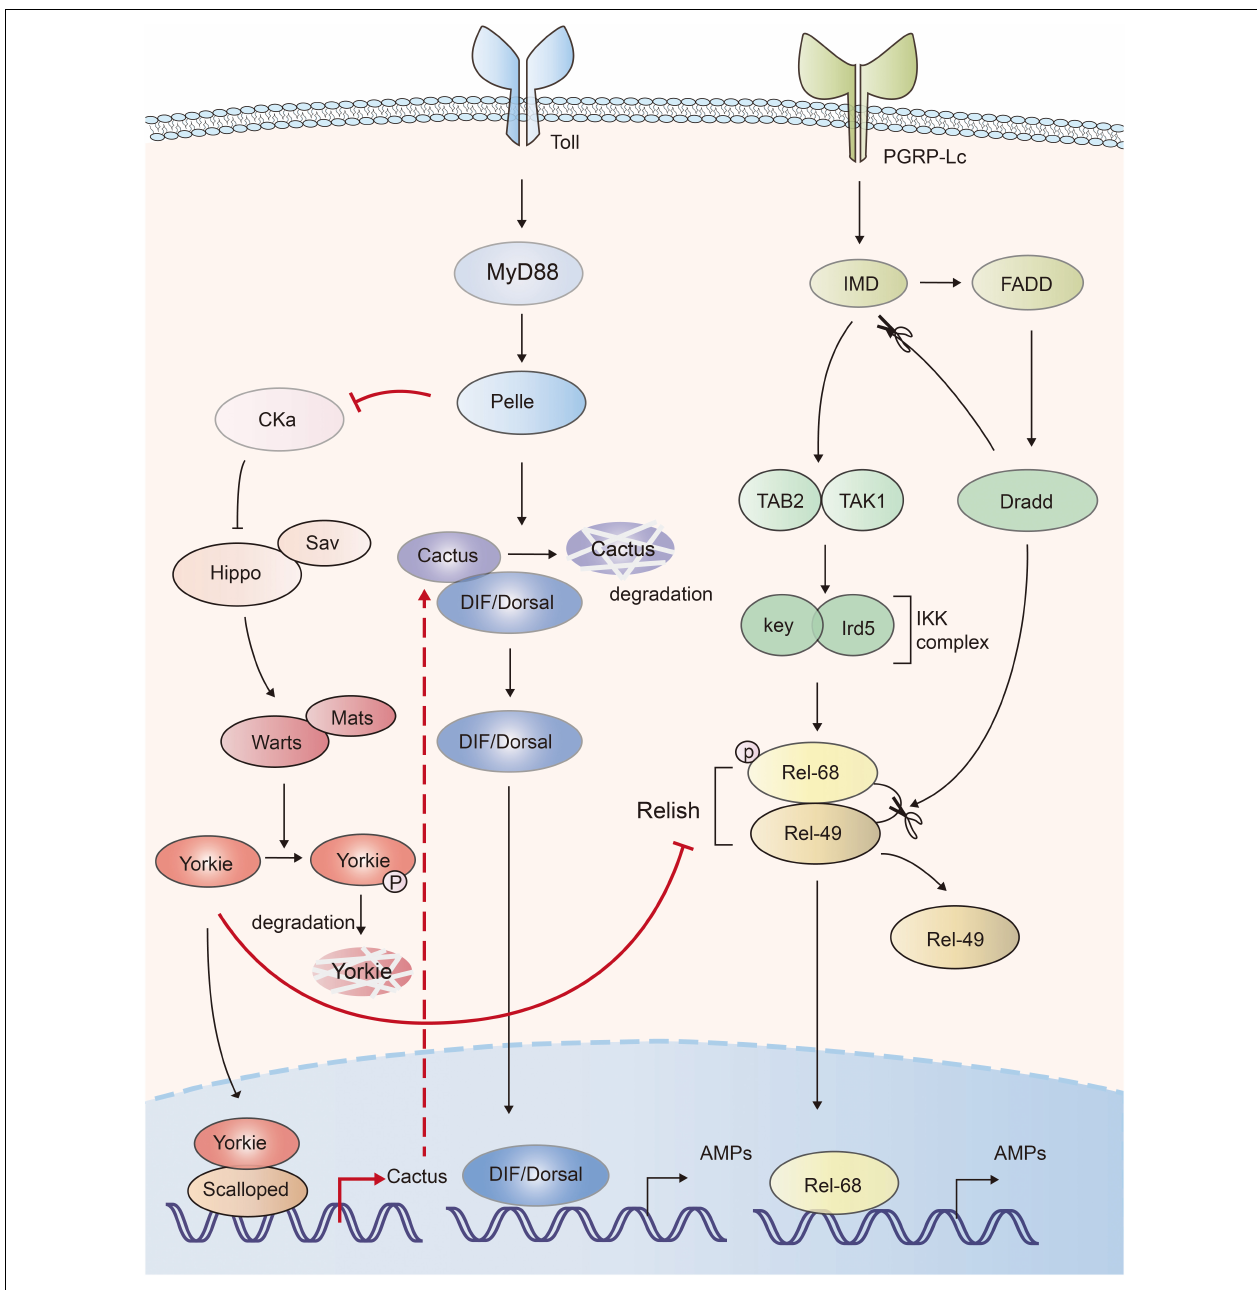
FIGURE 3 | The mutual activation of Hippo-Yorkie pathway and Toll/IMD mediated anti-bacterial response in Drosophila . Yorkie-Scalloped complex induce the expression of Cactus, which abolishes the activity of Drosophila the NF- κ B transcription factors dorsal/DIF and AMPs production. Yorkie also impairs the IMD pathway mediated AMPs production via suppressing the expression of Relish, the NF- κ B protein in IMD pathway. Activation of Toll receptor activates Hippo via Toll-Myd88-Pelle cascade mediated degradation of Cka. The interplays between Hippo-Yorkie and Toll/IMD pathway are highlighted with